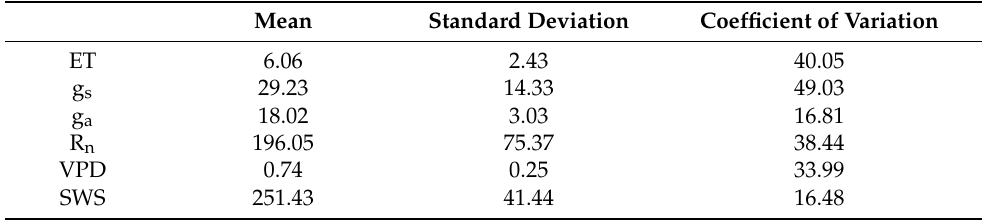
Table 1. Descriptive analyses of the monthly daily average of evapotranspiration (ET), bulk surface conductance (g s ), aerodynamic conductance (g a ), net radiation (R n ), vapor pressure deficit (VPD), and soil water storage (SWS) for the 2013–2019 period in a seasonally dry Atlantic tropical forest. Dataset used in the statistical